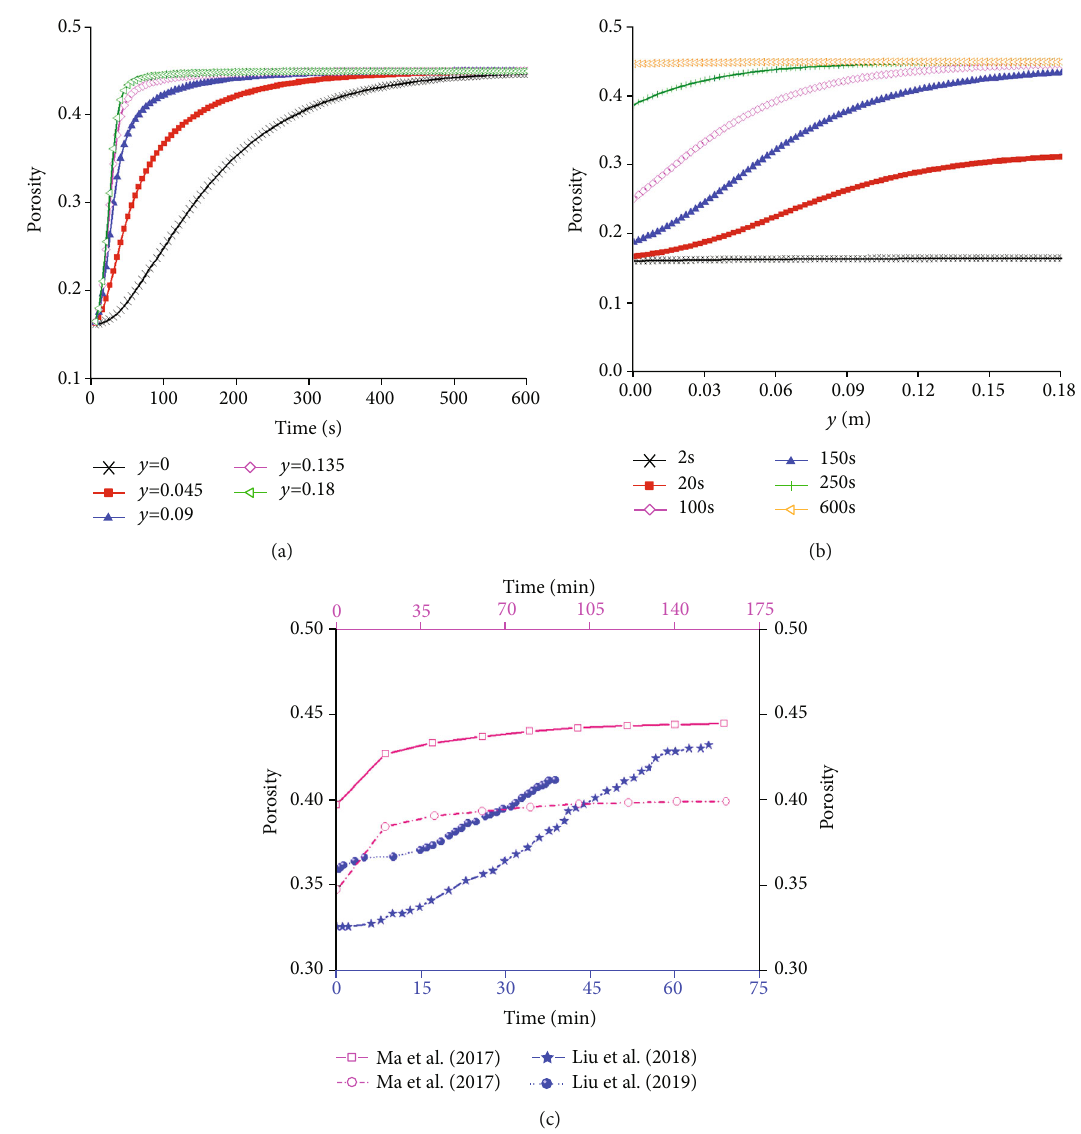
Figure 6: Evolution of porosity of broken rock mass: (a) over time, (b) with space, and (c) experimental results from